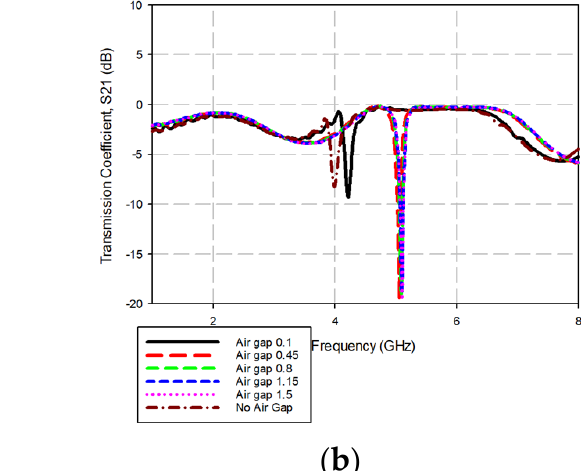
Figure 20. The air gap simulation response of ( a ) reflection coefficient and ( b ) transmission coefficient between MUT and resonator.